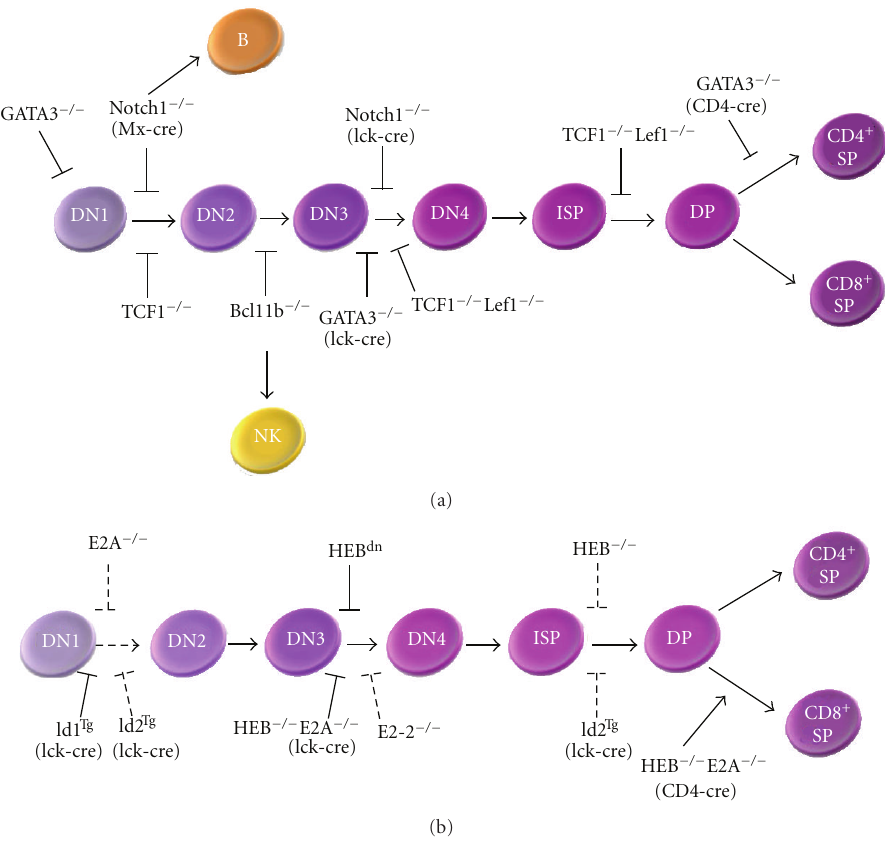
Figure 1: Key transcription factors in early T-cell development. Regulation of early T-cell development occurs through the coordinated action of transcription factors. (a) GATA3 is important for the generation of DN1 cells, and GATA3 − / − mice fail to produce any T-cells. Inactivation of GATA3 during DN stages results in a block at the DN3 stage due to defects in TCR β expression. When GATA is inactivated at the later stages of T-cell development, no CD4 SP cells can be generated. Notch1 signalling is indispensable for T-cell specification and commitment since mice deficient in Notch1 give rise to intrathymic B cells at the expense of T cells. Notch1 inactivation during DN stages arrests T-cell development at the DN3 stage due to the defects in V-(D)J rearrangements of the TCR β locus. Inactivation of TCF1 and LEF1 simultaneously results in the partial block at the DN3 stage and a complete block at the ISP stage as cells fail to rearrange TCR α locus. Lastly, Bcl11b is essential for the specification into the T-cell lineage. Bcl11b − / − cells fail to progress past the DN2 stage of T-cell development, and instead, di ff erentiate into NK cells. (b) T-cell blocks associated with mutations in HEB, E2A and/or E2-2 E-proteins and their antagonists, Id1 and Id2. Solid blunt lines indicate complete developmental arrest, while dotted blunt lines indicate a partial developmental arrest. DN: double negative, DP: double positive, SP: single positive, ISP: immature single positive, NK: natural killer, B: B